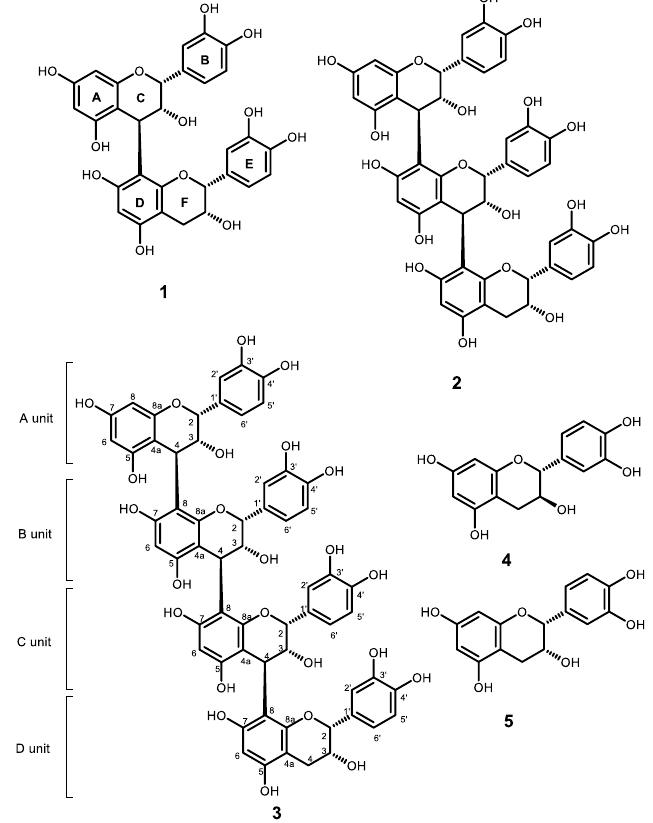
Figure 3. Chemical structures of compounds 1 – 5 . Compound 1 is a B-type